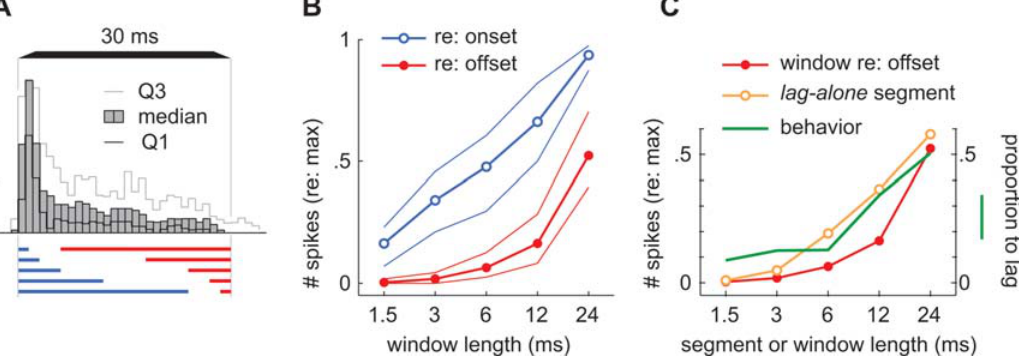
Figure 7. Potential explanation for localization dominance in the responses of neurons to single sounds. ( A ) PSTH showing the median neural responses that were evoked, in our sample of cells, by single-source targets (shown also in Fig. 2A). ( B ) Neural responses measured in time- windows of length and position that were the same as the lead-alone (onset; blue lines) or lag-alone segments (offset; red lines) under the standard paradigm. ( C ) Median responses evoked by lag-alone segments (orange line; shown also in Fig. 3A) and by single sounds during equivalent time- windows (red line; redrawn from panel A ). The green line shows the proportion of lag-directed saccades for all subjects under the standard paradigm (shown also in Fig.